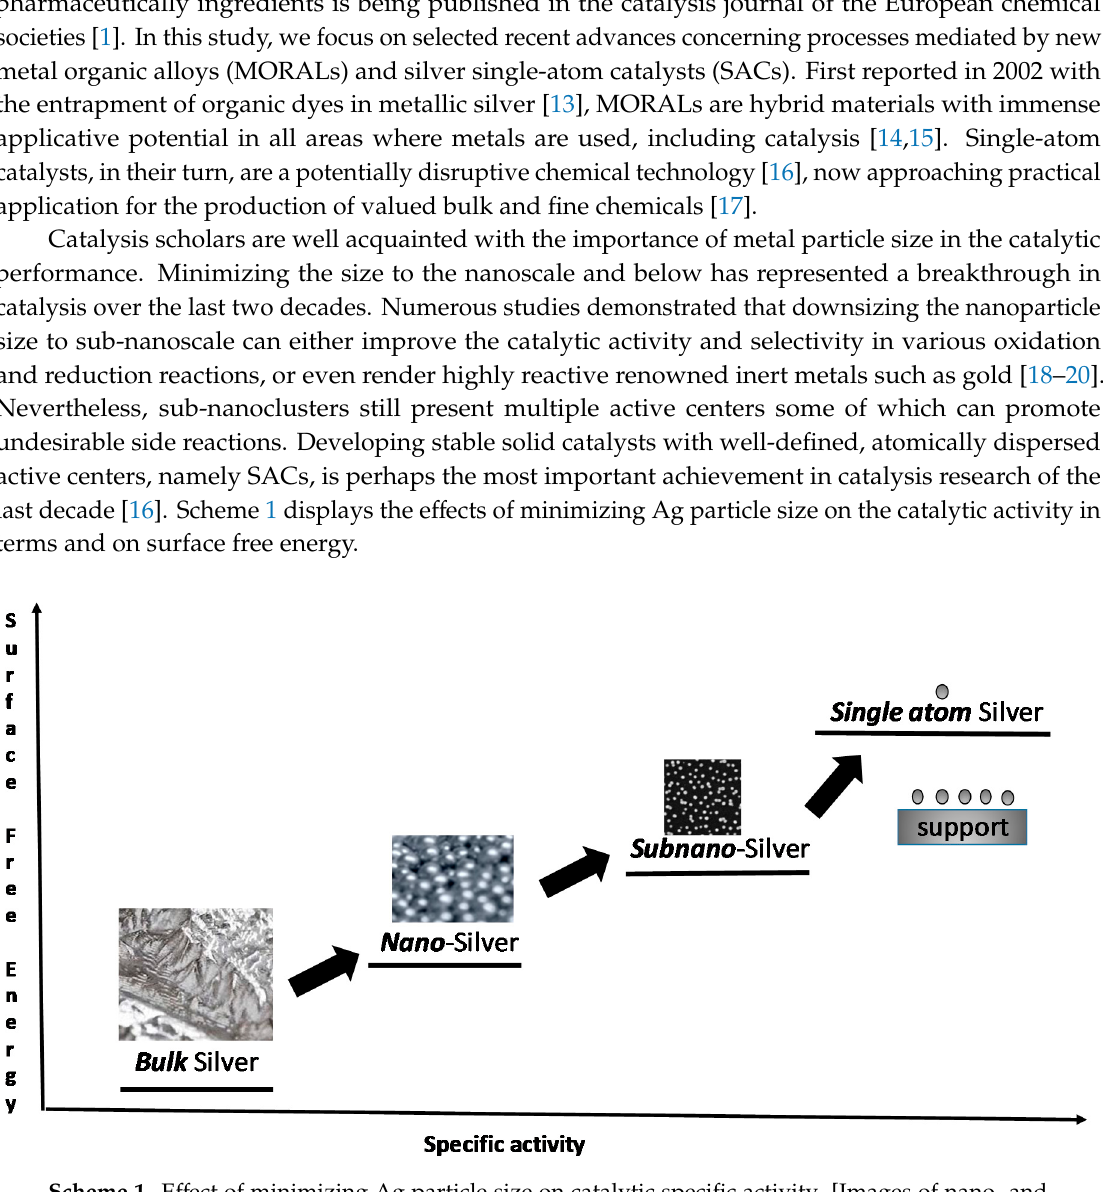
Scheme 1. Effect of minimizing Ag particle size on catalytic specific activity. [Images of nano-